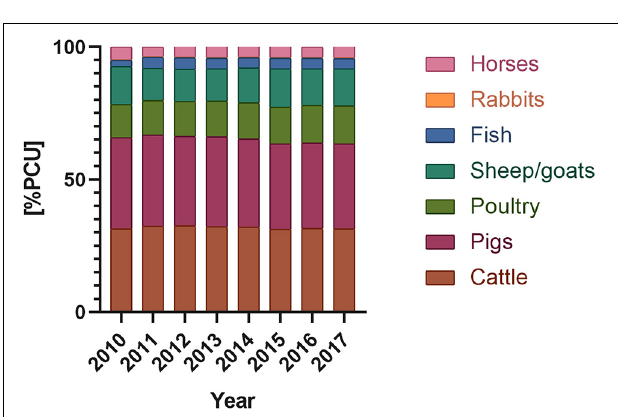
FIGURE 2 | Antimicrobials used in domestic animals (according to according to ECDC/EFSA/EMA second joint report on the integrated analysis of the consumption of antimicrobial agents and occurrence of antimicrobial resistance in bacteria from humans and food-producing animals, 2017) [PCU] – population corrected unit; PCU a technical unit of measurement, used only to estimate sales corrected by the animal population in the individual countries; 1 PCU = 1 kg of different categories of livestock and slaughtered